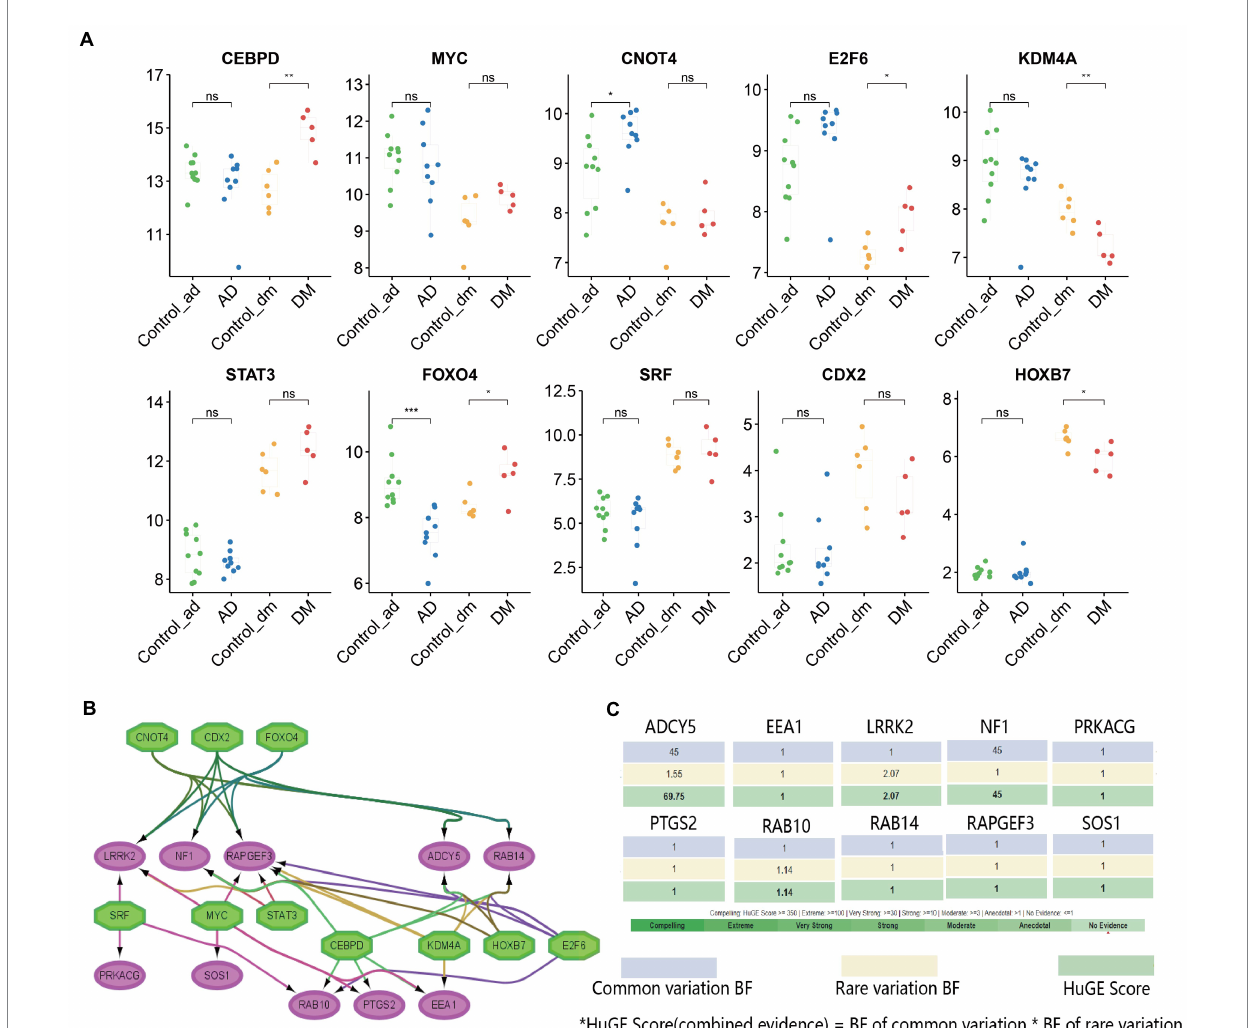
FIGURE 9 TFs regulatory network and its expression in GSE97760 and GSE95849. (A) The expression level of TFs in GSE97760 and GSE95849. The comparison between the two sets of data uses the mean T -test. * p < 0.05, ** p < 0.01, *** p < 0.001, (B) TFs regulatory network. TFs were marked in green, and the hub genes were marked in red, and (C) Evidence from human genetics can provide important support for hypotheses about the roles of genes in DM via the HuGE Calculator.